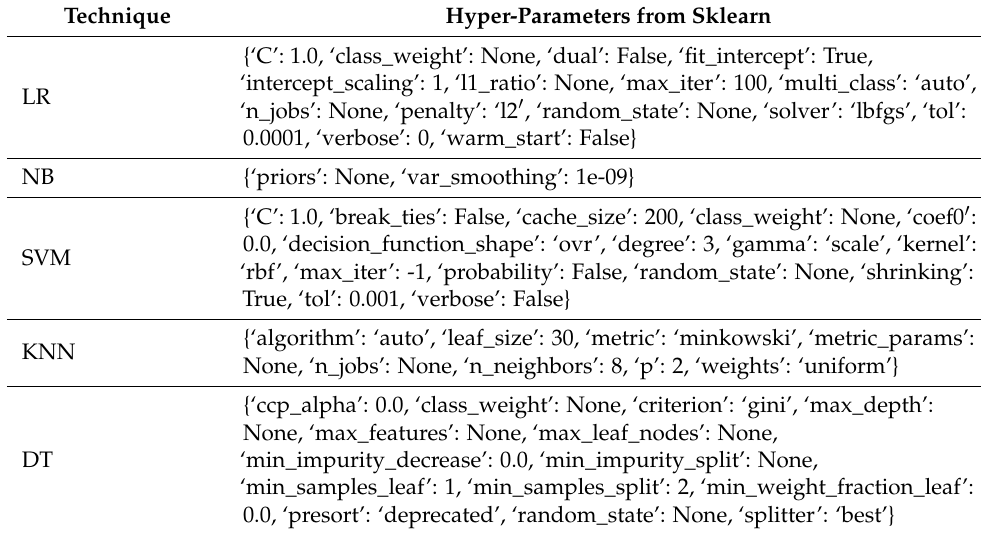
Table 2. Model of